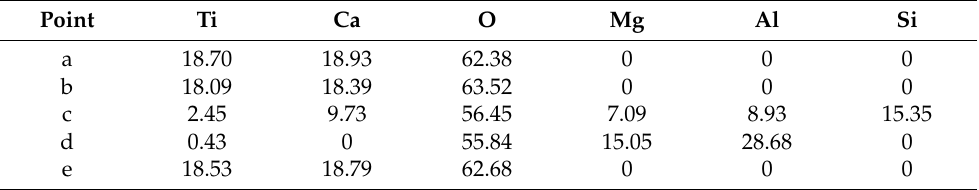
Figure 2. Pseudo ternary phase diagram of the TiO 2 -CaO-SiO 2 -Al 2 O 3 -MgO system. The red dots from left to right represent the samples with basicity of 1.1 to 1.4. Table 3. EDS composition distribution corresponding to Figure 4a (a–d points) and Figure 4j (e point)